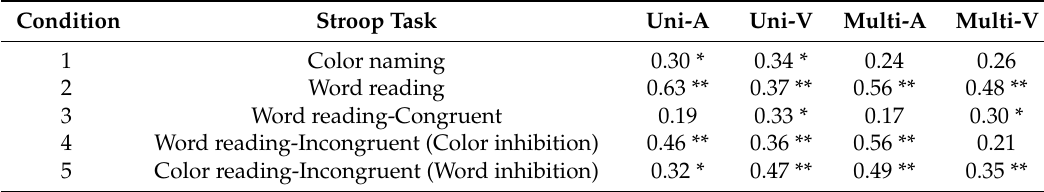
Color reading-Incongruent (Word